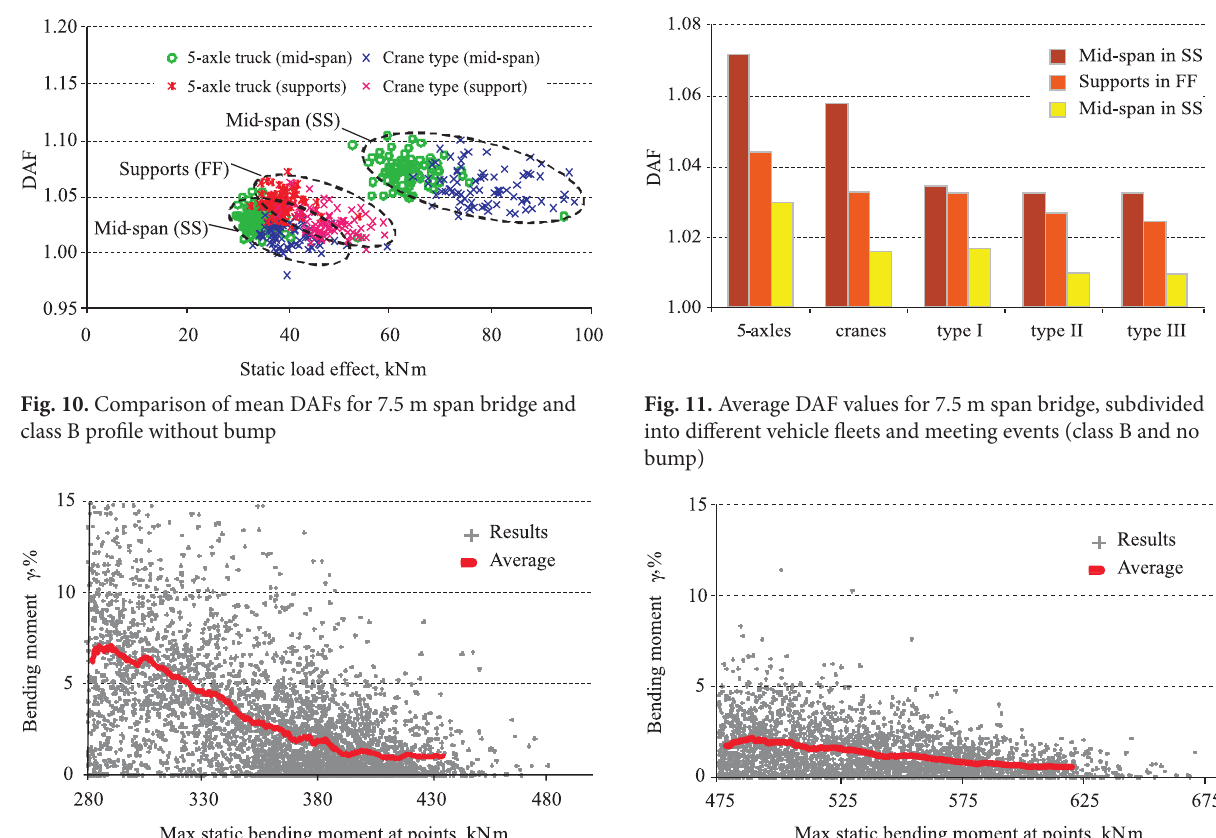
spantype Fig. 12. Gamma values on 25 m